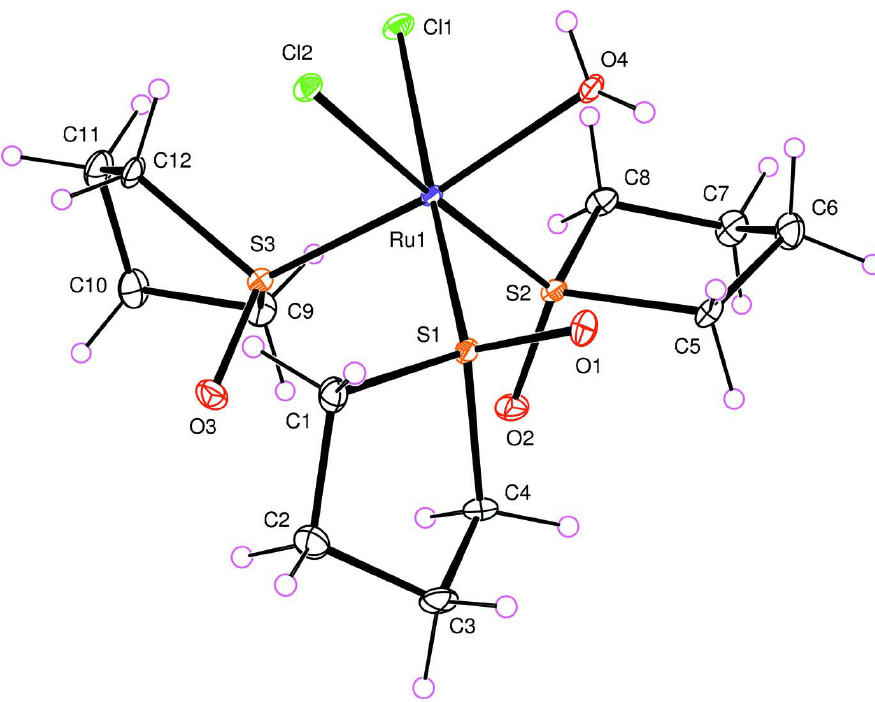
Figure 1 A plot of the title compound with displacement ellipsoids drawn at the 50% level and H atoms having arbitrary